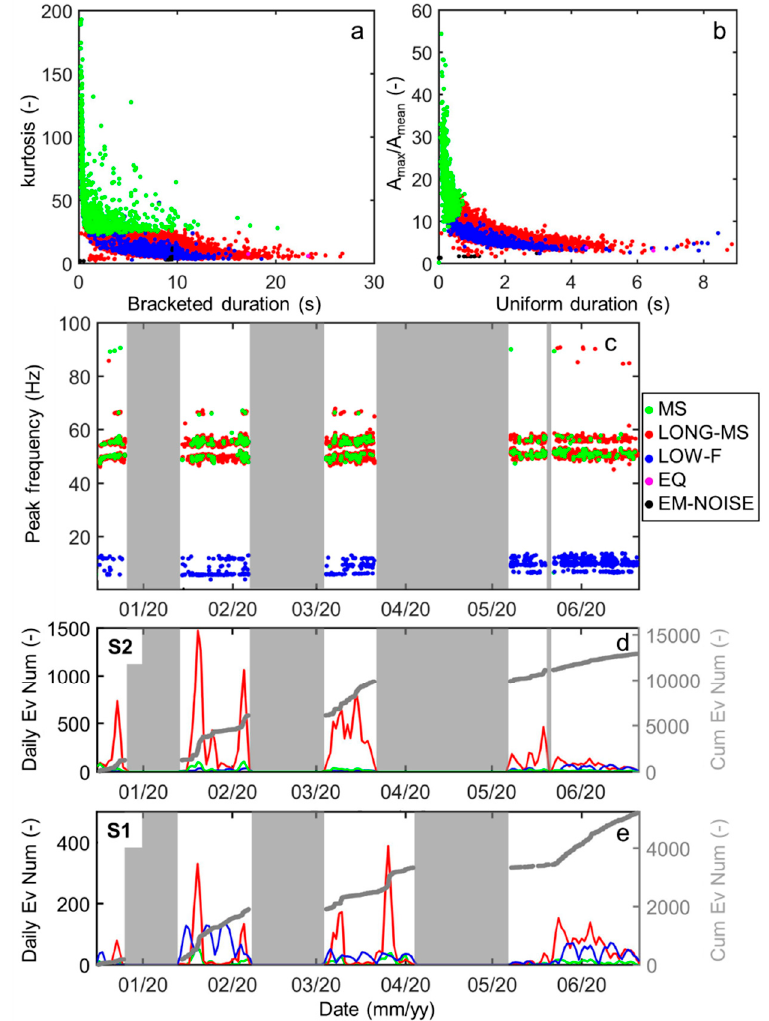
Figure 10. Automatically classified seismic events derived from the ambient seismic noise data set (MS in green, LONG-MS in red, LOW-F in blue, EQ in magenta, EM-NOISE in black). ( a ) kurtosis vs. bracketed duration plot of the classified events. ( b ) Maximum amplitude of the signal normalized to the average value computed over the whole signal duration plotted in comparison with the event uniform duration. ( c ) Peak frequency evolution in time of MS, LONG-MS, LOW-F events. ( d – e ) Daily and cumulative event number of MS, LONG-MS, LOW-F events recorded at (d) S2 (tower top) and ( e ) S1 (reference station). The y-scales in ( d ) are three times bigger than the ones in ( e ). No data periods are shaded in gray for each station. Table 2. Number of events recorded at the four monitoring stations.